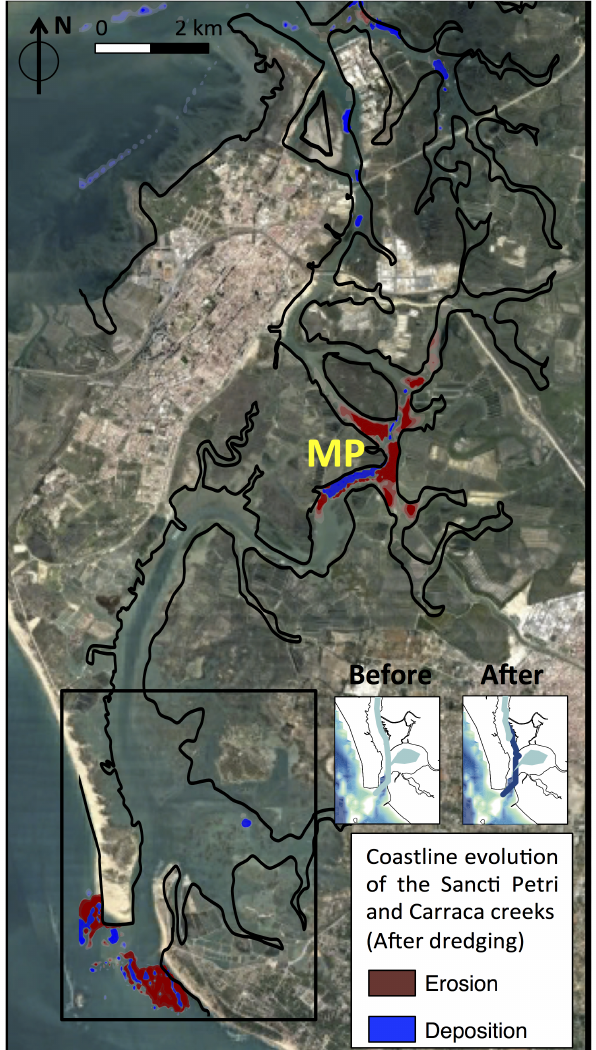
Figure 15. Net evolution of the bottom elevation (mm) computed by the bed evolution model at the end of the simulation considering the deepening of the navigation channel at SPC. Insets represent the bathymetry before and after the